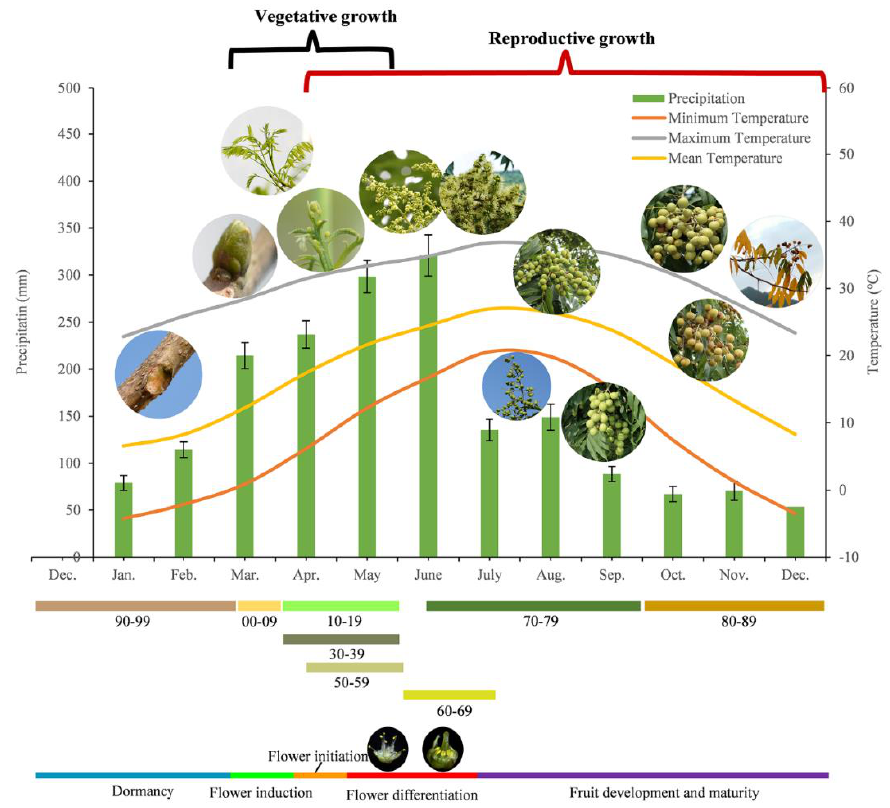
Figure 1. Main phenological growth stages of S. mukorossi according to the BBCH scale. Time elapsed in each stage (horizontal bars), 50 years’ average data of precipitation and mean, maximum, and minimum temperatures. Table 1. Phenological growth stages of S. mukorossi according to the BBCH scale. BBCH Code